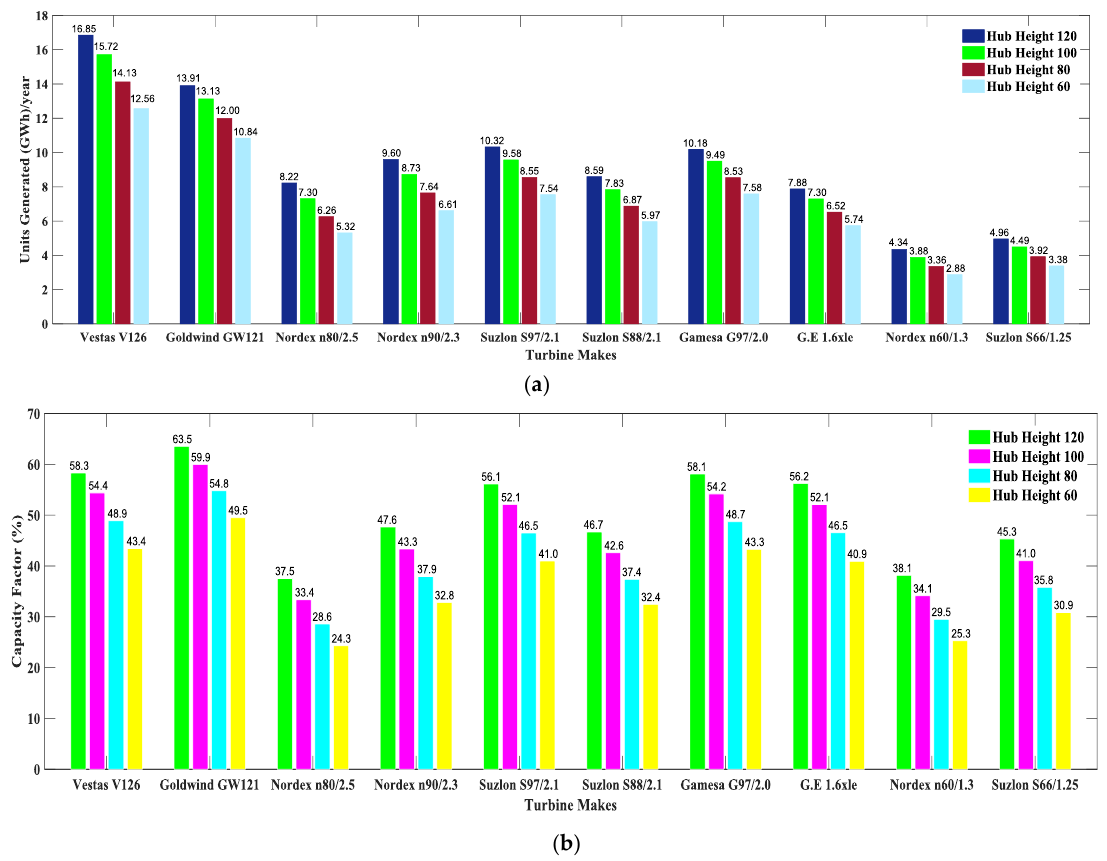
Figure 15. Production capacity of various wind turbine prototypes at different heights ( a ) the average